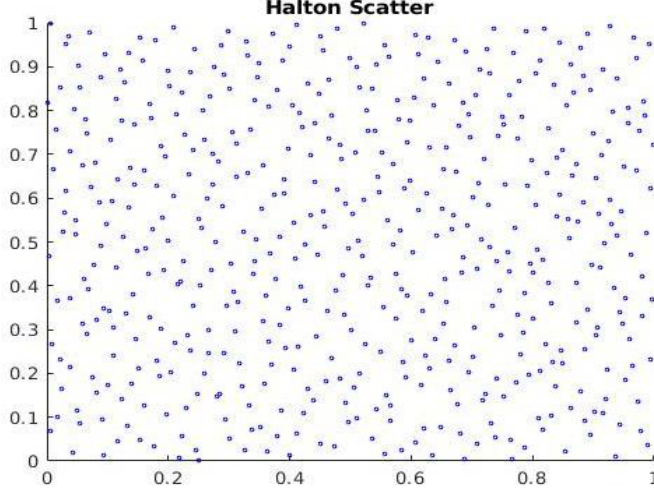
Figure 3. Sample points generated using Halton distribution.